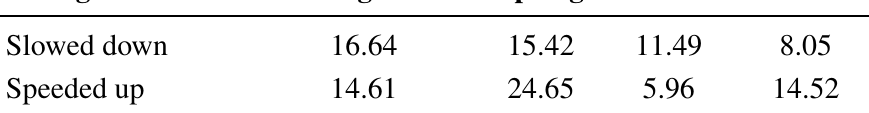
Table 4. Proportion of areas with slowed down or speeded up NDVI trends since abrupt change points